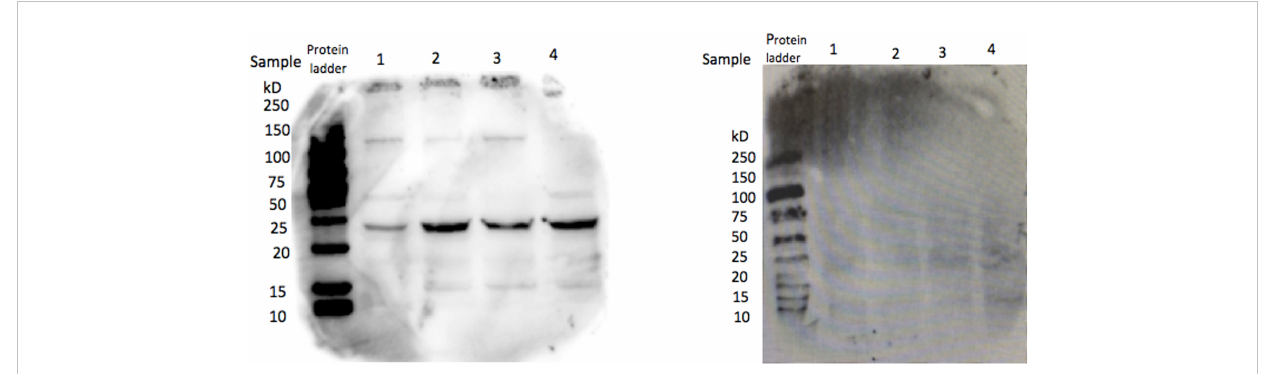
FIGURE 3 CRH protein in cat placental tissue. Western Blot analysis revealed the presence of a ~22 kDa protein in four placental tissue samples, consistent with the size of CRH preprohormone (left), whereas serum without primary antibody served as a negative control (right).